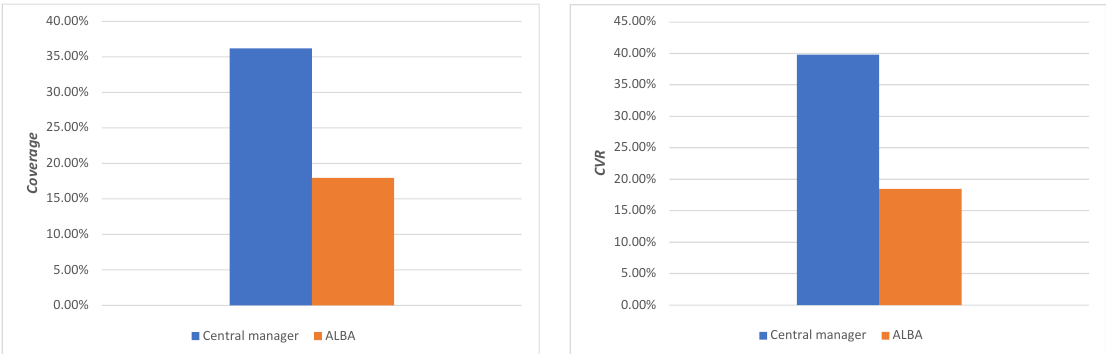
Figure 5. Security metrics comparison of ALBA and Central managers.